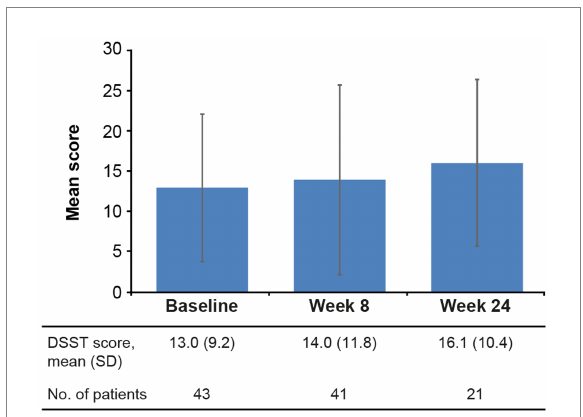
FIGURE 4 Mean (SD) DSST total score at baseline and after 8 and 24 weeks of vortioxetine treatment (effectiveness analysis set). DSST, Digit Symbol Substitution Test; SD, standard